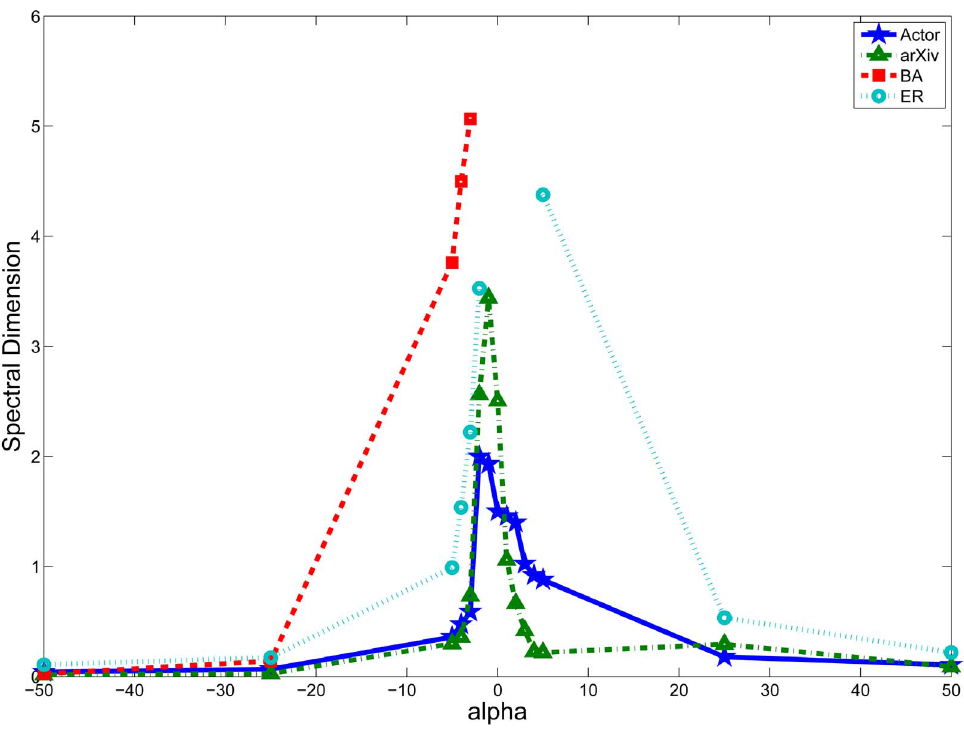
Figure 4. Relationship between spectral dimension d s and the weighting factor a . The data used for drawing this figure is tabulated in Table 3. The lines corresponding to BA and ER network appear disconnected as they have d s ~ ? for certain values of a and cannot be adequately shown in the figure. The spectral dimension generally peaks in the interval [ 2 1, 1] and drops significantly for a of greater magnitude. This is especially true for the BA and ER networks (from infinity to a finite value). In the extreme case, by setting a ~ ? , the ‘random walk’ is no longer random as the node with largest degree will always be chosen at every step. Similar reasoning also applies for a ~{ ? . Therefore, towards both extremes, we would expect the random walk to become more localized and hence falls into the compact exploration